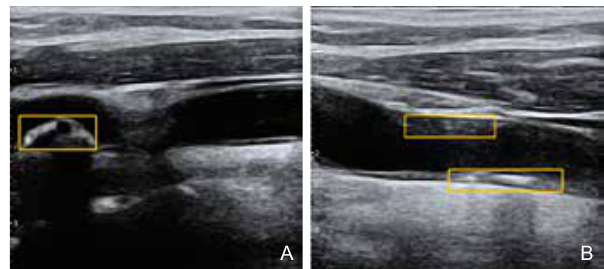
Figure 3 (A) Single plaque in the common carotid artery; (B) Multiple plaques (anterior and posterior) in the common carotid